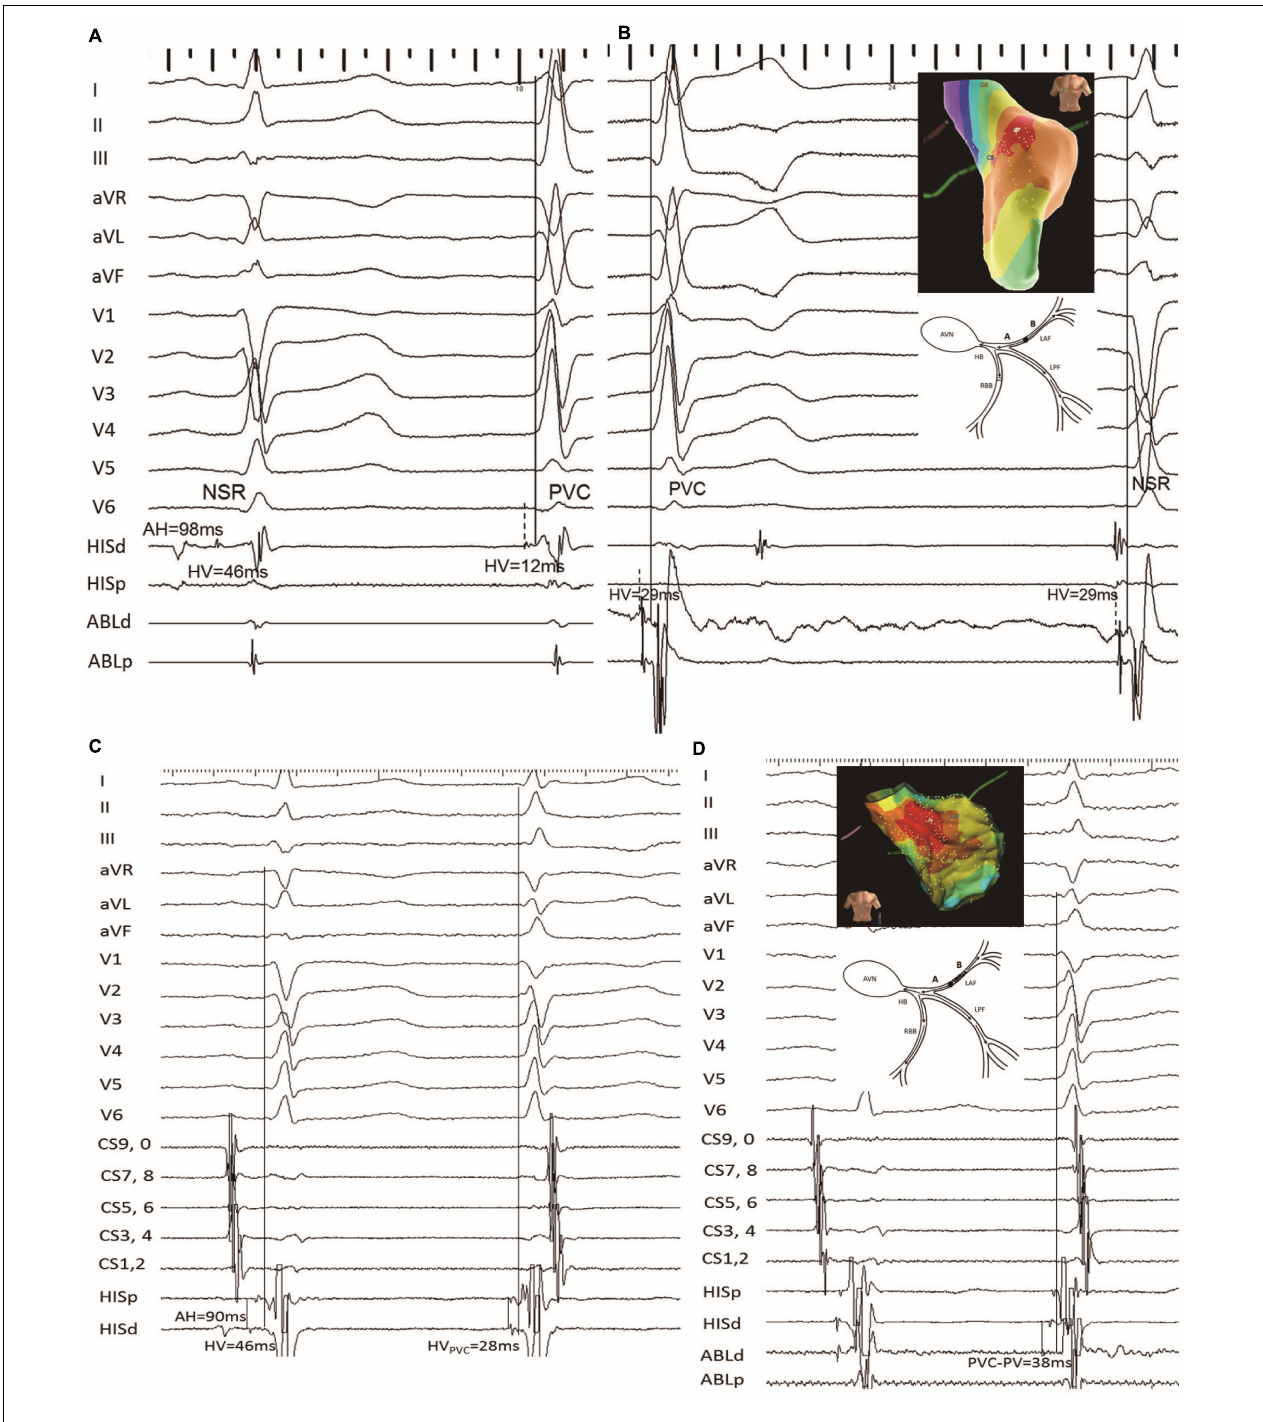
FIGURE 5 | Another example of failed LAF-PVC case (patient 8). (A) The HV intervals during SNR and PVC with the mapping electrode positioned at the His bundle were 46 and 12, respectively; it is noted that the predicted value was 29 ms. (B) The catheter was positioned at the target site with recordings of local anterior PP-the onset of surface ECG interval of 29 ms during PVC. Three-dimensional activation mapping of the left anterior area shows the target site. (C) The HV NSR interval was the same as that of the first procedure, while the HV PVC interval was 28 ms; the QRS duration ratio of NSR/PVC increased from 0.75 to 0.95; and the QRS morphology of PVC was similar to the NSR-QRS morphology. (D) The earliest retrograde PP with 38 ms was mapped and had successful ablation. Three-dimensional activation mapping of the left anterior area showed the target site and a schematic diagram showing the slow conduction within the LAF fiber, which might explain the reason for the narrower QRS. It is noted that the target PP was fragmented during PVC. CS, coronary sinus; the other abbreviations are as in Figure 2 .